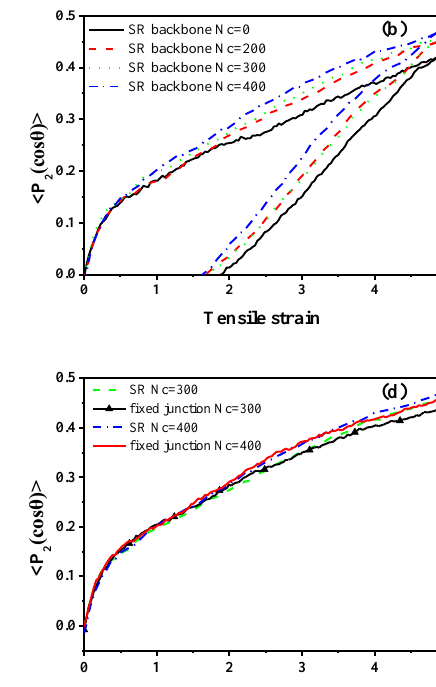
Figure 6. Stretch-recovery curves for different number of cross-linked bonds, and Nc in ( a ) the fixed junction systems and ( b ) SR systems.